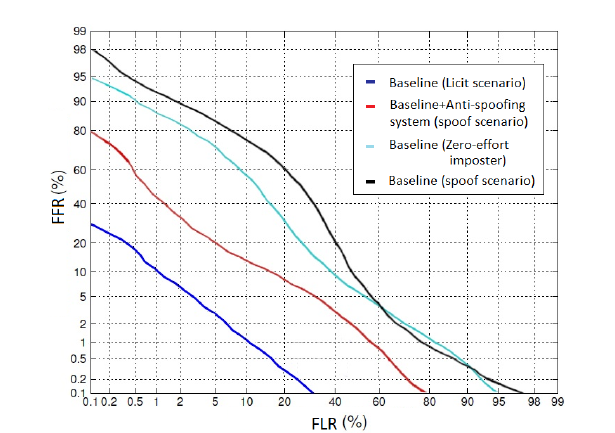
Figure 6. False Fake Rate (FFR) and False Living Rate (FLR) of the proposed biometric system with/without